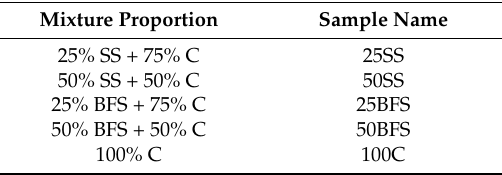
Table 3. Tested sampled